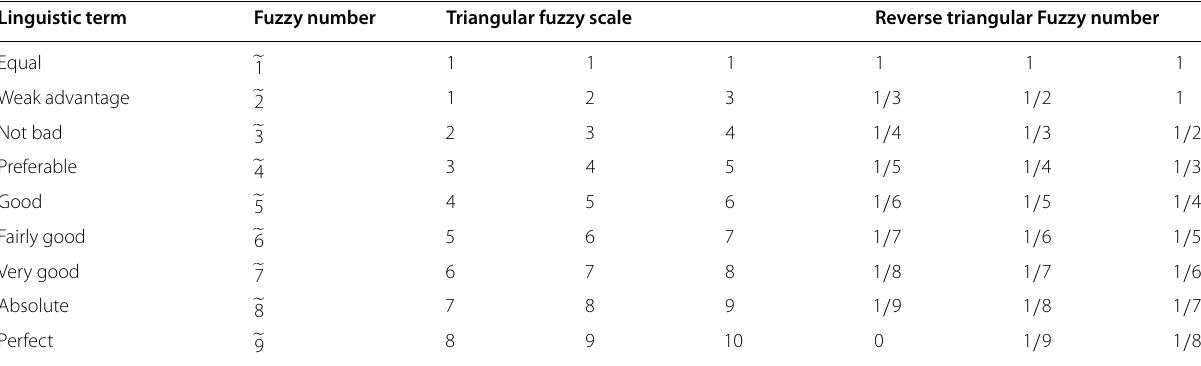
Table 2 Linguistic scales of criteria ratings for FAHP Linguistic term Fuzzy number Triangular fuzzy scale Reverse triangular Fuzzy number